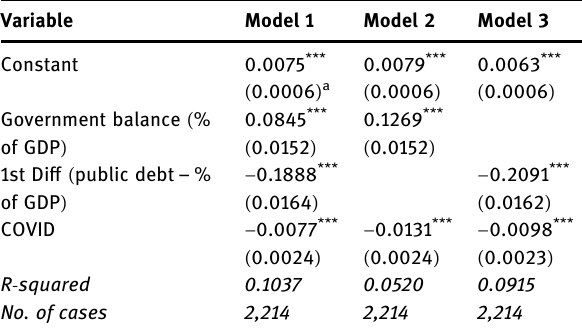
Table 10: Regression models ’ estimation Variable Model